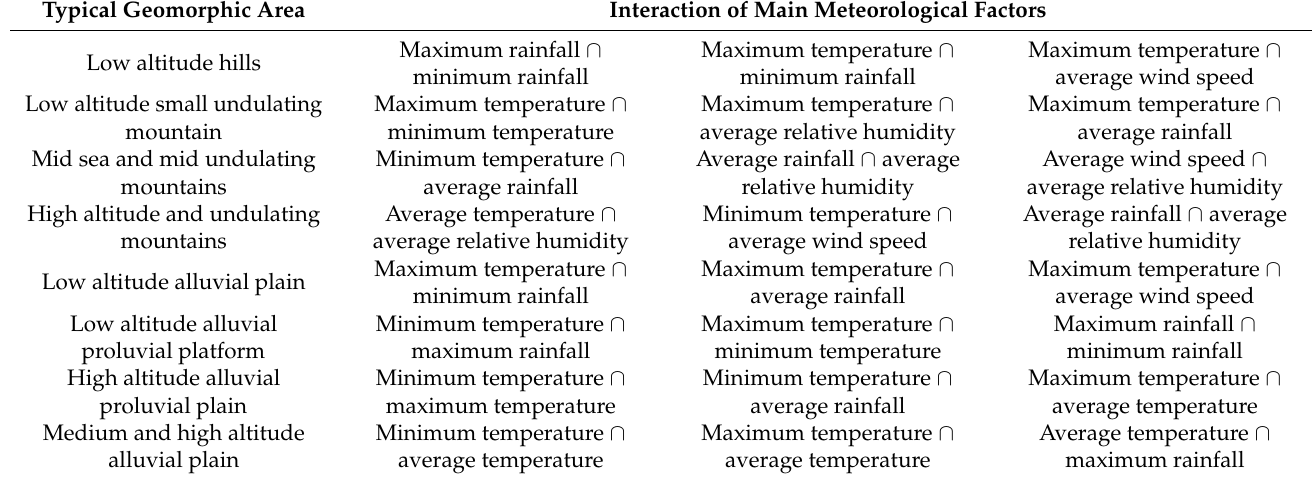
Table 1. Interaction detection of influencing factors on cultivated land spatial distribution in different geomorphic